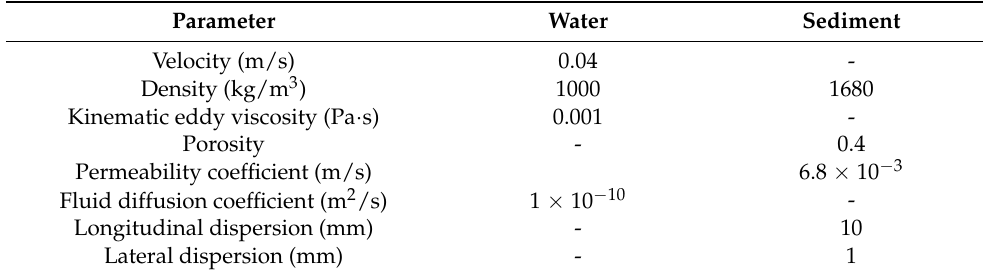
Table 2. Parameters used in the numerical model. Parameter Water